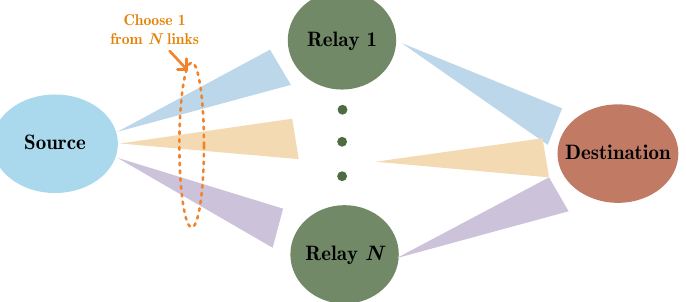
Figure 2. System structure of a DF-FSO system.